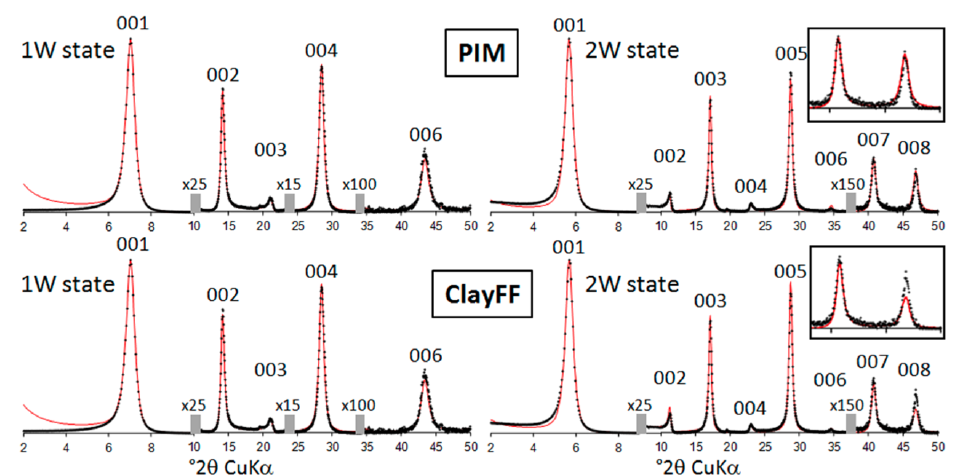
Figure 4. Experimental (black crosses) and calculated (red lines) intensities of 00l reflections for hectorite under monohydrated (1W-left) and bihydrated (2W-right) state and using PIM (top) or ClayFF (bottom) models. The vertical gray bars indicate a modified scale factor for the high-angle regions as compared to the low-angle part of the patterns. 00l reflections are indexed on the top part of the figure. For 2W state, a zoom of the 007 and 008 reflections is shown for both